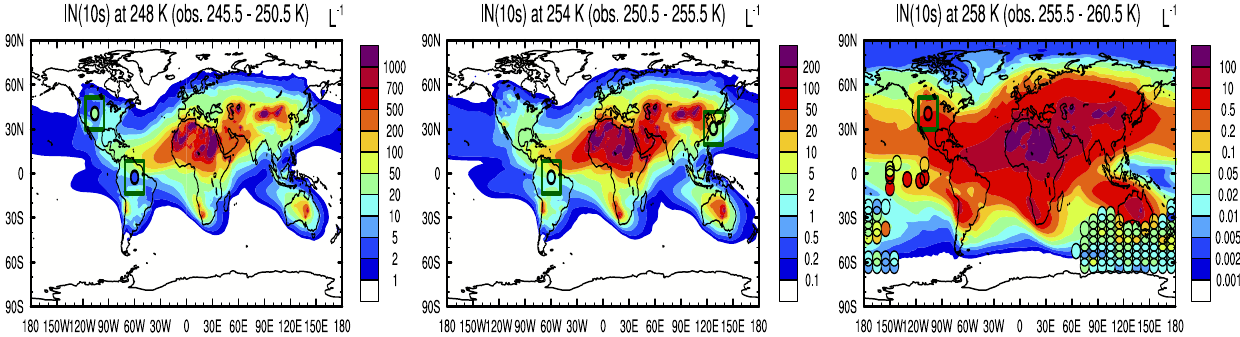
Figure 12. Spatial comparison of IN(10s) concentration with field data. IN(10s) concentrations are sampled for three specific temperatures, which fall into the same range of observed temperatures as chosen for measurements at the near-surface layer. The field IN measurements are indicated by colored circles (DeMott et al. (2010) in the central USA; Rosinski et al. (1987) in the central Pacific; Rosinski et al. (1995) in the East China Sea; Bigg et al. (1973) to the south of Australia). Field IN measurements in the East China Sea, Brazil and the central USA are highlighted by dark green rectangles to show them more